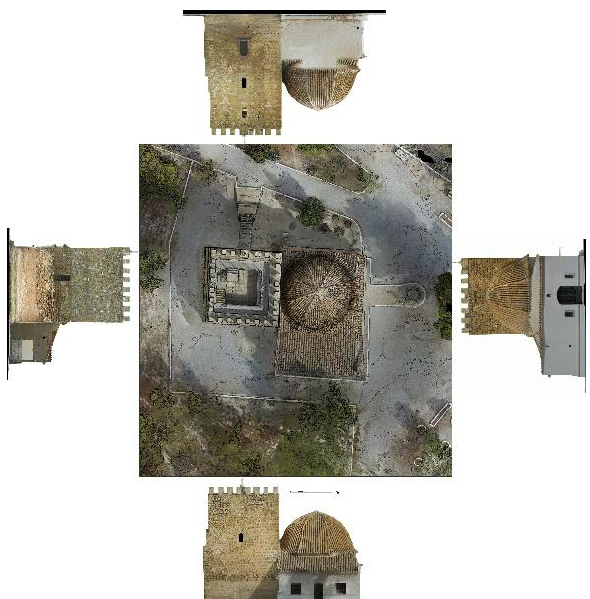
Figure 2. Photogrammetric survey of the medieval Tower of the Ancestors ( Torre del Alabí ) and the eighteenth century chapel attached to it in Cúllar (Province of Granada,